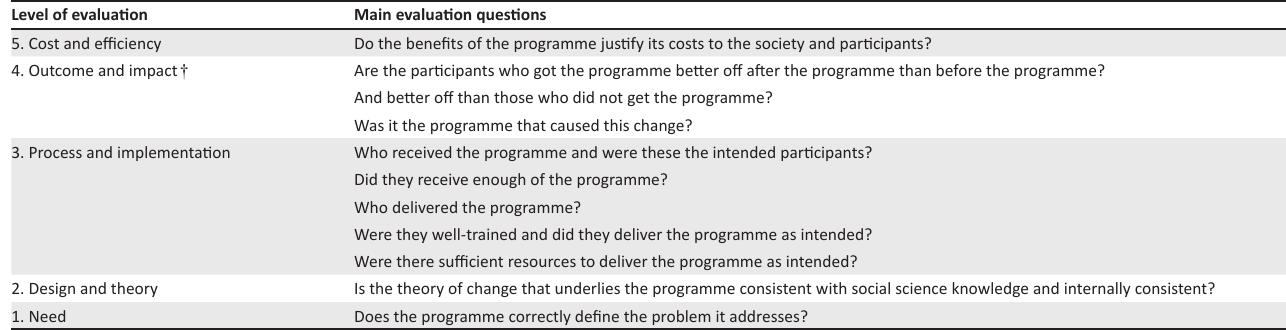
TABLE 1: Evaluation levels and questions. Level of evaluation